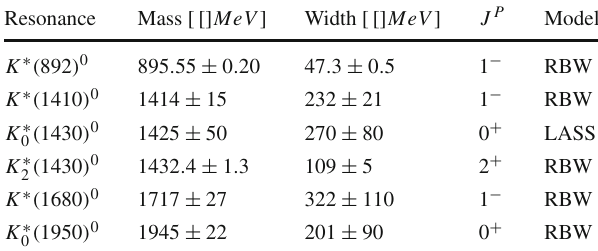
Table 3 Resonances included in the baseline model, where parameters and uncertainties are taken from Ref. [52]. The LASS lineshape also